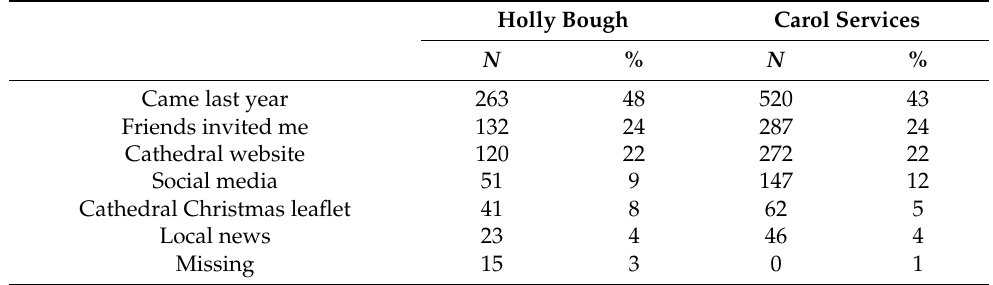
Table 7. Hearing about the service.